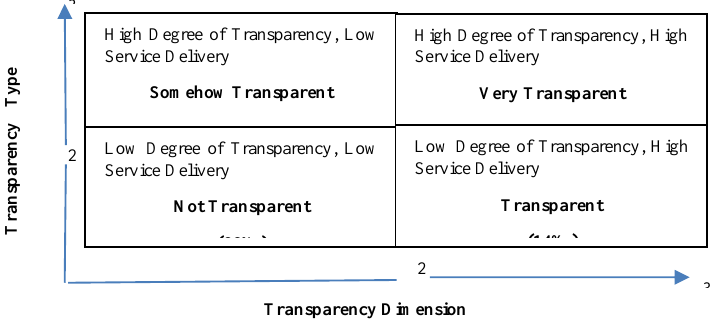
Fig. 4: Typology of Degree Transparency and Service Delivery